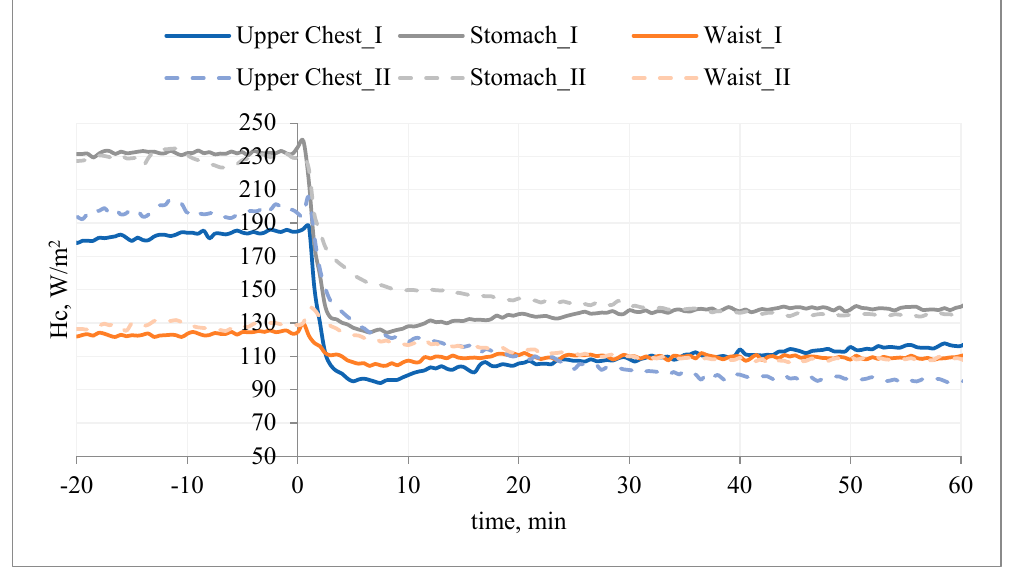
Figure 7. An example of the heat flux density, Hc, on selected manikin segments (chest) during testing of type A undergarments without PCM (variant I) and with PCM (variant II).